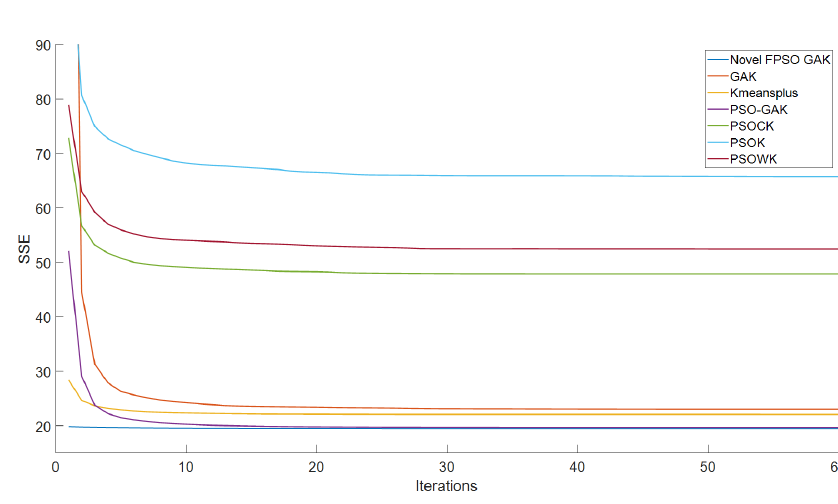
Figure 9. The SSE convergence curve of taxi GPS dataset from Aracaju